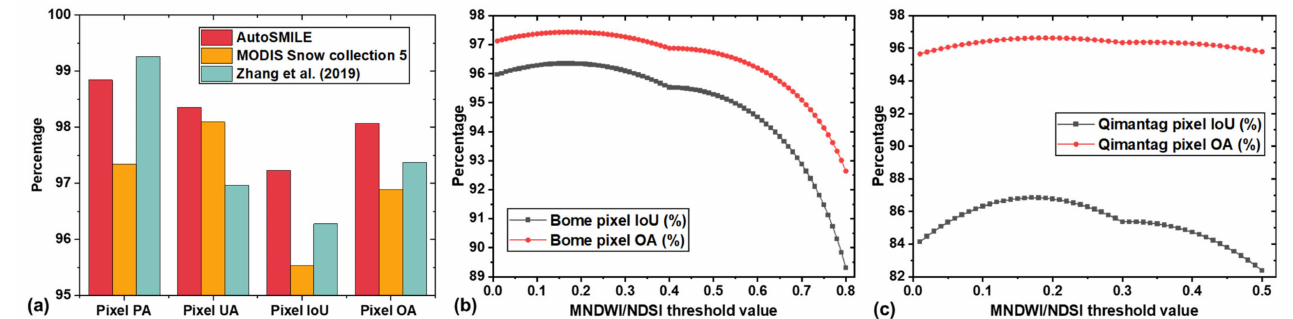
Figure 11. Results of the comparative study: ( a ) performance of different methods over the study area in Bome County (excluding the training zone); ( b ) performance of MNDWI/NDSI-based method as functions of threshold value over the study area in Bome County (excluding the training zone); ( c ) performance of MNDWI/NDSI-based method as functions of threshold value over the new testing zone in the Qimantag Mountain region. (PA: producer’s accuracy; UA: user’s accuracy; IoU: intersection over union; OA: overall accuracy; MNDWI: modified normalized difference water index; and NDSI: normalized difference snow